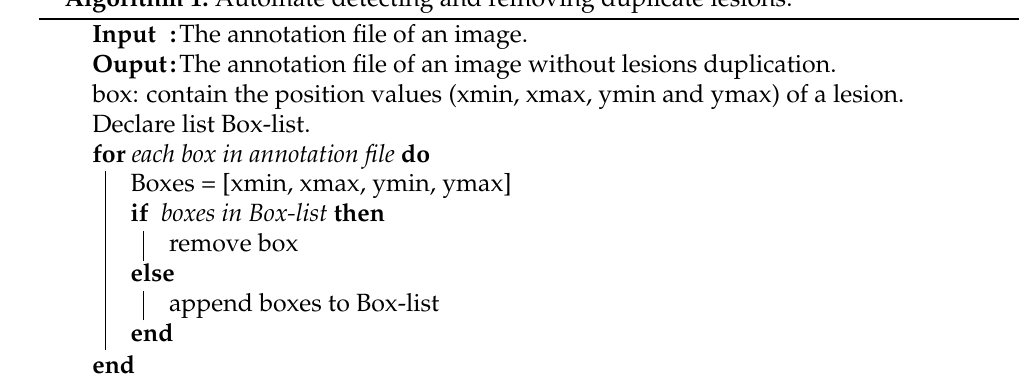
Algorithm 1: Automate detecting and removing duplicate